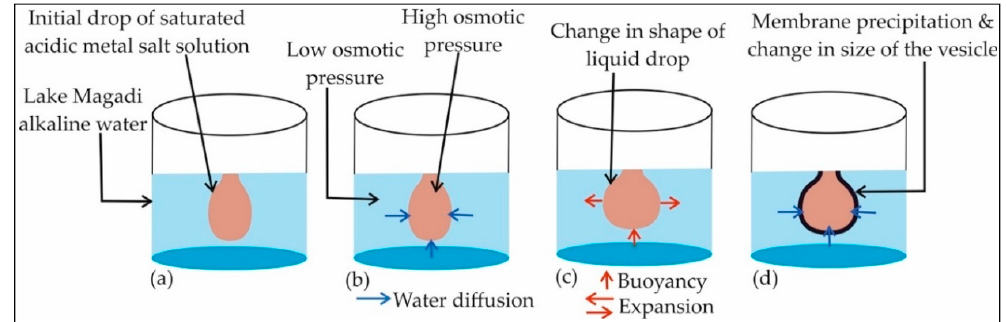
Figure 16. Illustration of the growth process of the Magadi vesicles from metal salt solution drops in Lake Magadi water.